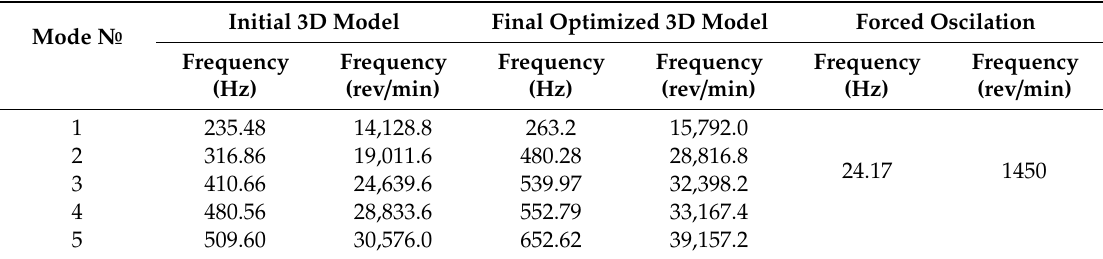
Table 5. Obtained results for the first four modes and natural frequencies.